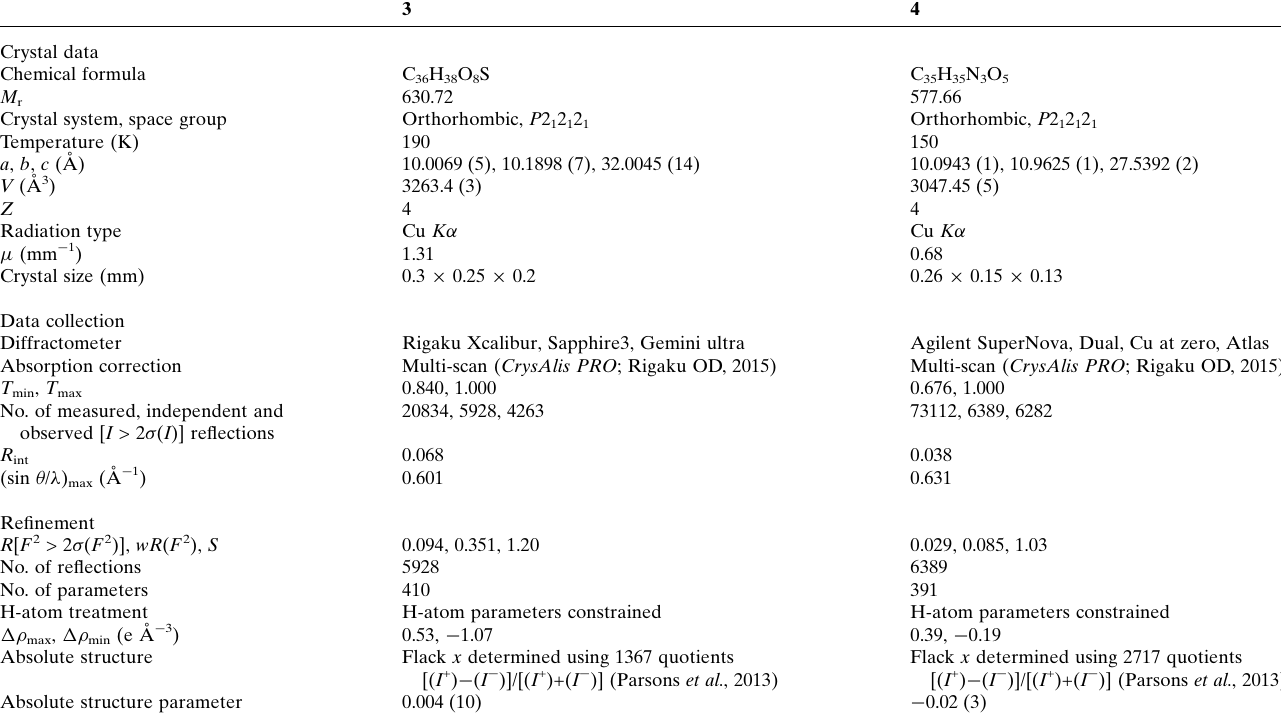
Table 3 Experimental details.